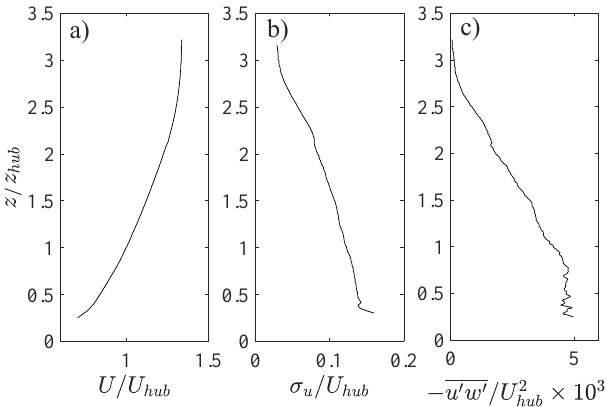
Figure 2. Main characteristics of the incoming turbulent boundary layer flow. ( a ) time-averaged velocity U / U hub ; ( b ) streamwise turbulence intensity σ u / U hub ; ( c ) kinematic shear stress − ¯ u ′ v ′ / U 2 The vertical distances are normalized by the turbine hub height z hub